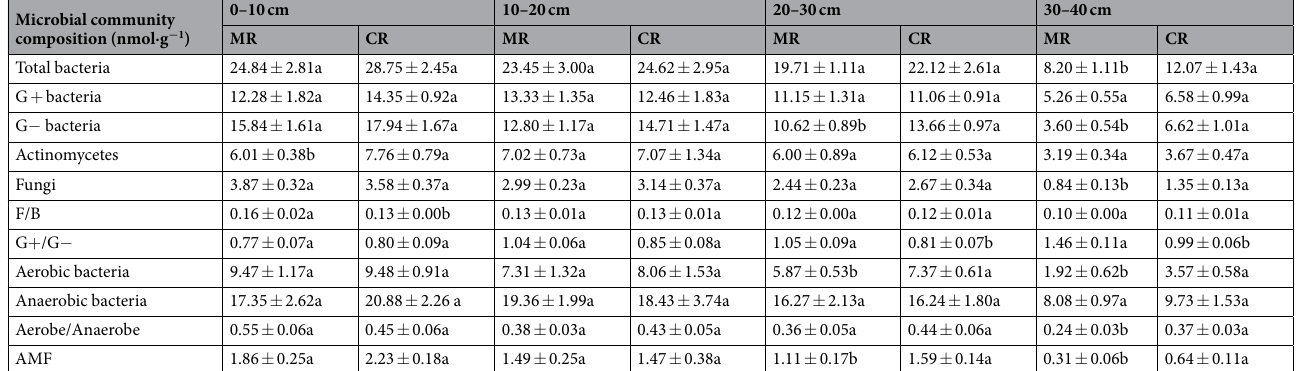
Table 4. Soil microbial community composition under different treatments. MR, rice monoculture model; CR, Integrated rice–crayfish model. G + , gram–positive bacteria, G − , gram–negative bacteria, F/B, ratio of fungal to bacterial PLFAs; G + /G − , the ratio of gram–positive to gram–negative bacteria; AMF, arbuscular mycorrhizal fungi; Aerobe/Anaerobe, the ratio of aerobic to anaerobic bacteria. Means with different letters for the same property in the same soil layer indicate significant differences at p < 0.05. Values are means ± standard